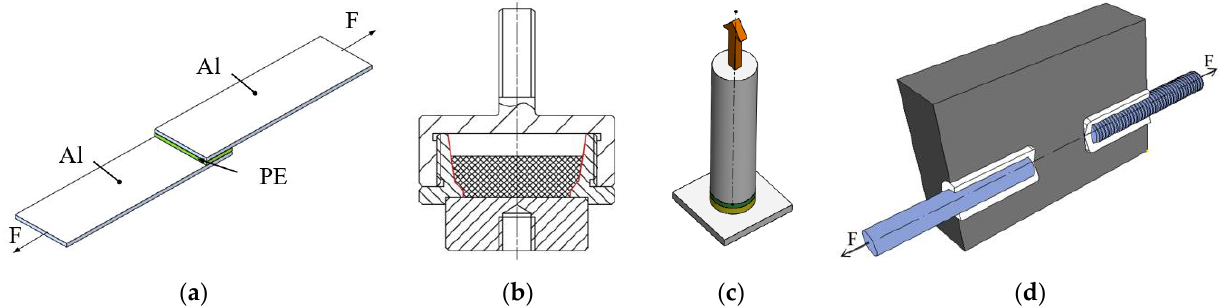
Figure 1. Strength testing methods ( a ) lap-shear test [32]; ( b ) pull-off test with mold [28]; ( c ) pull-off test with dolly [33]; ( d ) pull-out test [33].